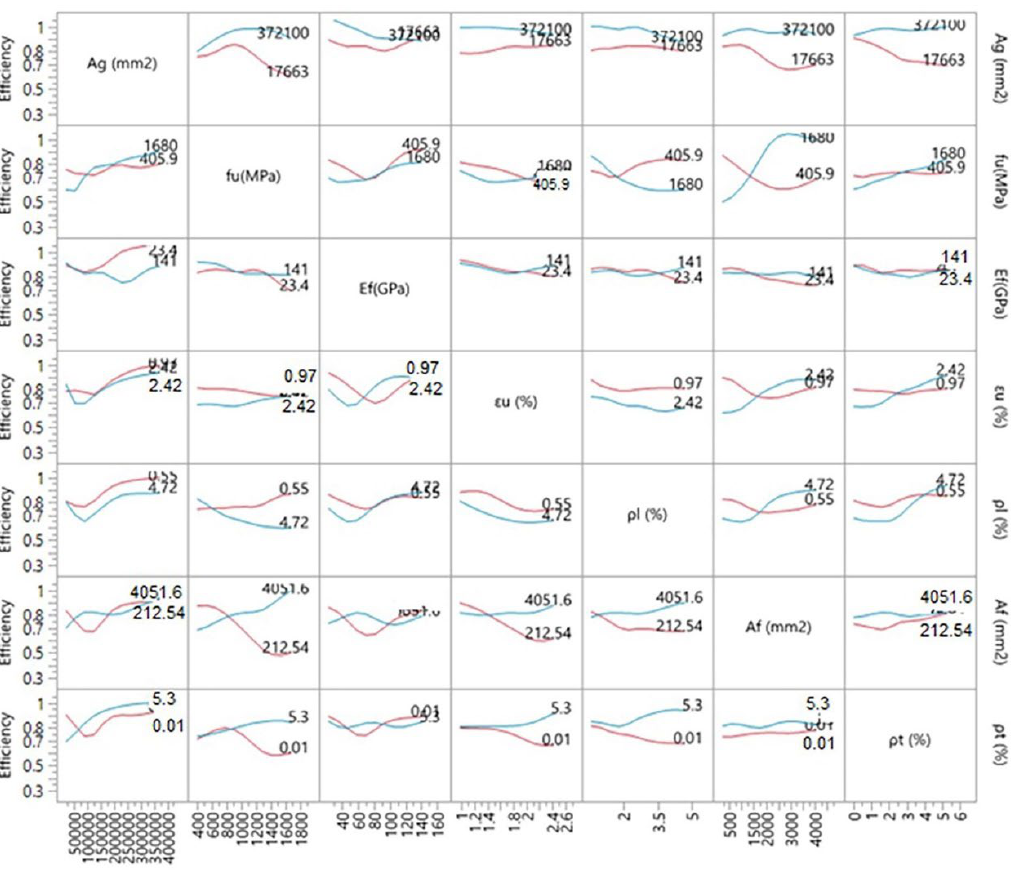
Figure 7. Interaction profiler between efficiency and seven different parameters for GFRP - made RC columns.